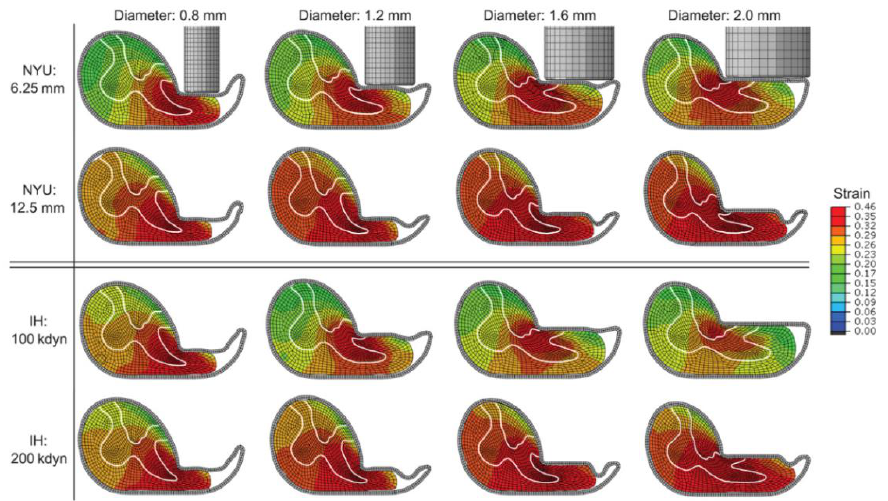
Figure 5. Strain distributions in the transverse view at the maximum compression for the NYU and IH impactors at impactor tip diameters of 0.8 mm, 1.2 mm, 1.6 mm, and 2.0 mm. Appl. Sci. 2020 , 10 , x